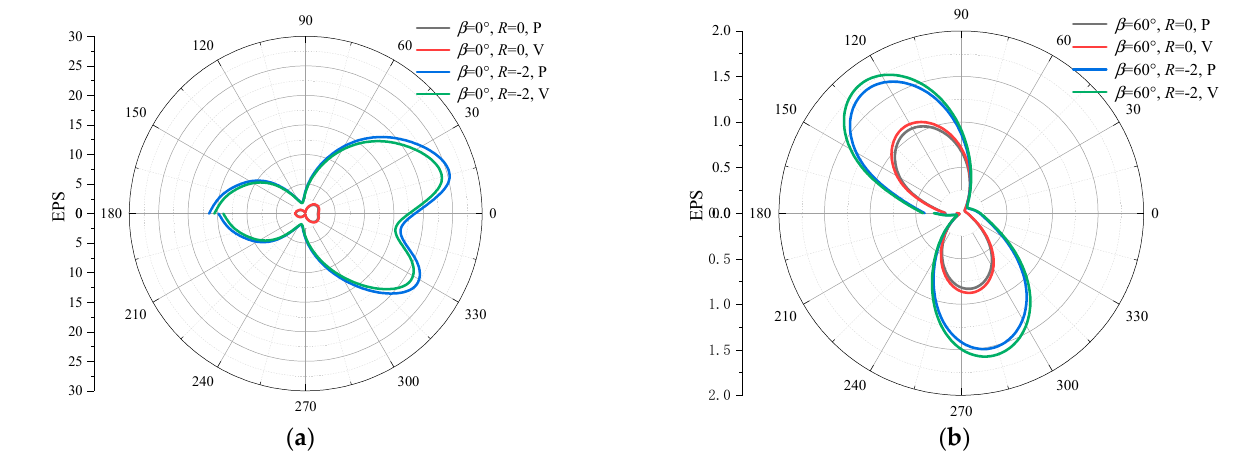
( b ) Figure 17. EPS field with loading history: ( a ) β = 0°, ( b ) β = 60°. In addition, for pure mode II crack, the increasing process of EPS with loading history is less affected by loading ratio R (shown in Figure 17a). In contrast, for I-II mixed mode crack under β = 60°, the increasing law of EPS with the loading history is much more in- fluenced by loading ratio R (shown in Figure 17b), which is similar to that of mode I crack in Figure 9. It is mainly due to the fact that there is no crack contact closure in the mode II crack, while there is contact closure of the mode I component in the I-II mixed mode crack, which hinders plastic strain accumulation at the crack tip to a certain degree. The circular distribution of EPS is given in Figure 18. The EPS field of mode II and I- II mixed mode crack tip shows a symmetrical shape. For pure mode II crack under β = 0 ˚ , the EPS of the specimen under R = − 2 is much greater than that under R = 0 in Figure 18a.